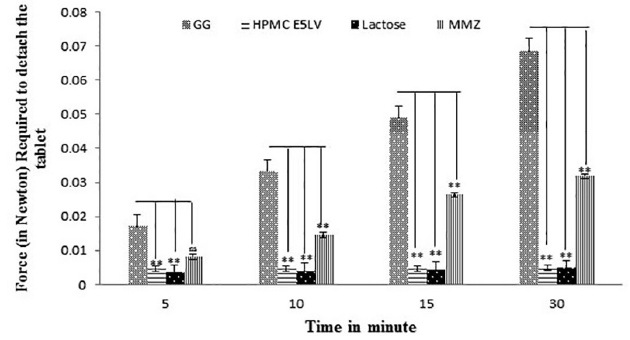
FIGURE 4 - Compression between mucoadhesive strength of Guar Gum and HPMC E5LV (Standard) and MMZ (Test Materials) and Lactose (Control). Values are expressed as mean